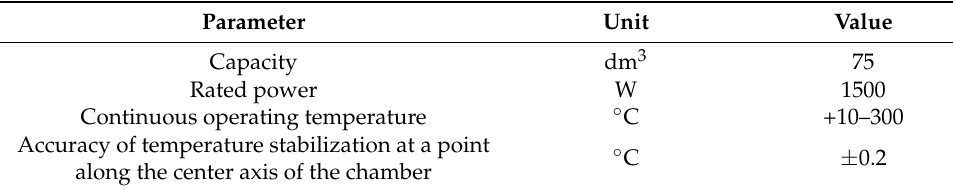
Table 1. Technical specification of WAMED KBC-65W laboratory dryer.